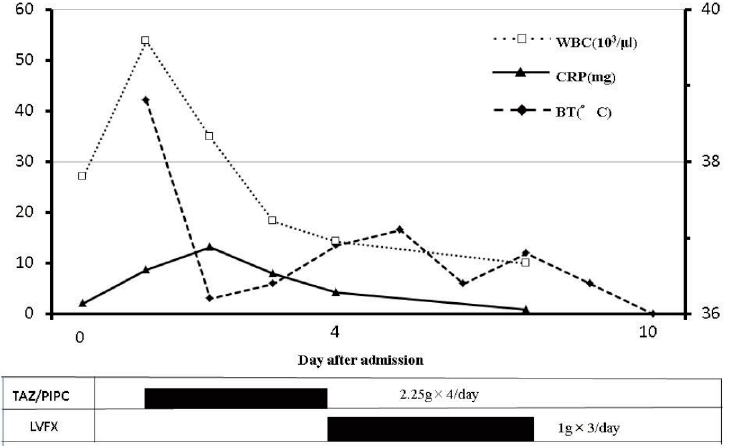
Figure 3. The time course of treatments and inflammatory changes. Intravenous antibiotic treatment was started on day 0. WBC, white blood cell; CRP, C-reactive protein; BT, body temperature. The wound of the left maxilla was checked at 8 days from the day of discharge, and we confirmed that the wound was clear and there were no aberrant symptoms.